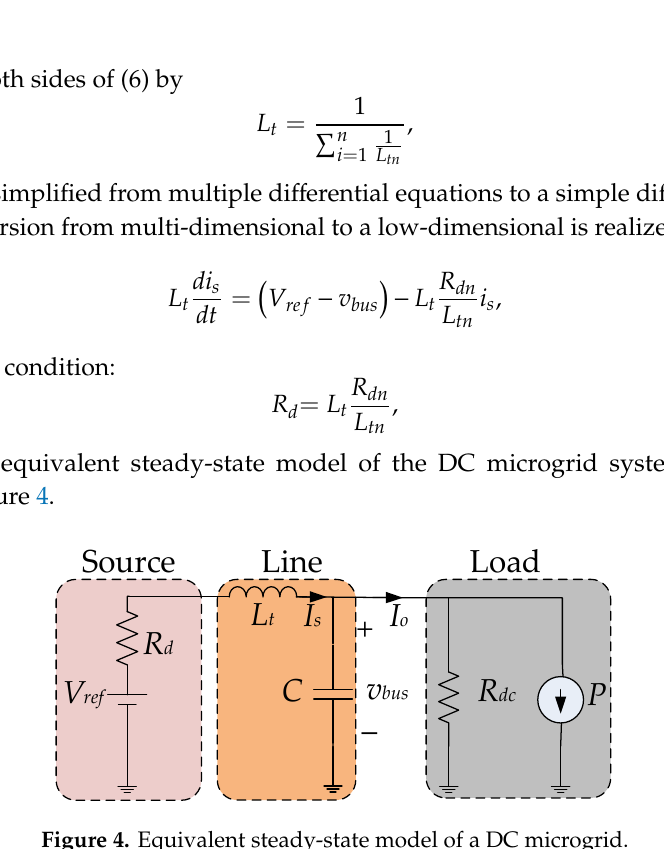
Figure 4. Equivalent steady-state model of a DC microgrid.